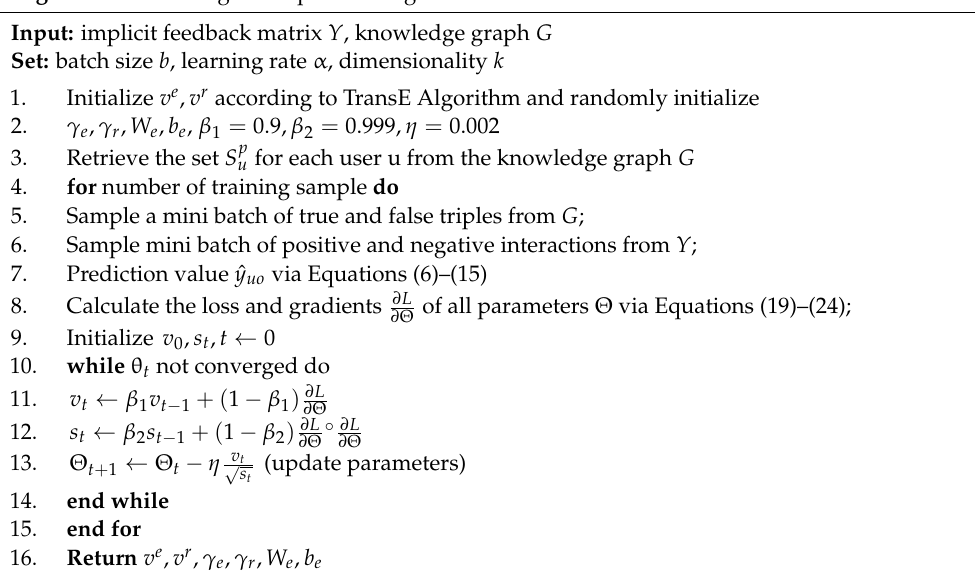
Algorithm 1 Learning in the pre-training for EKPNet